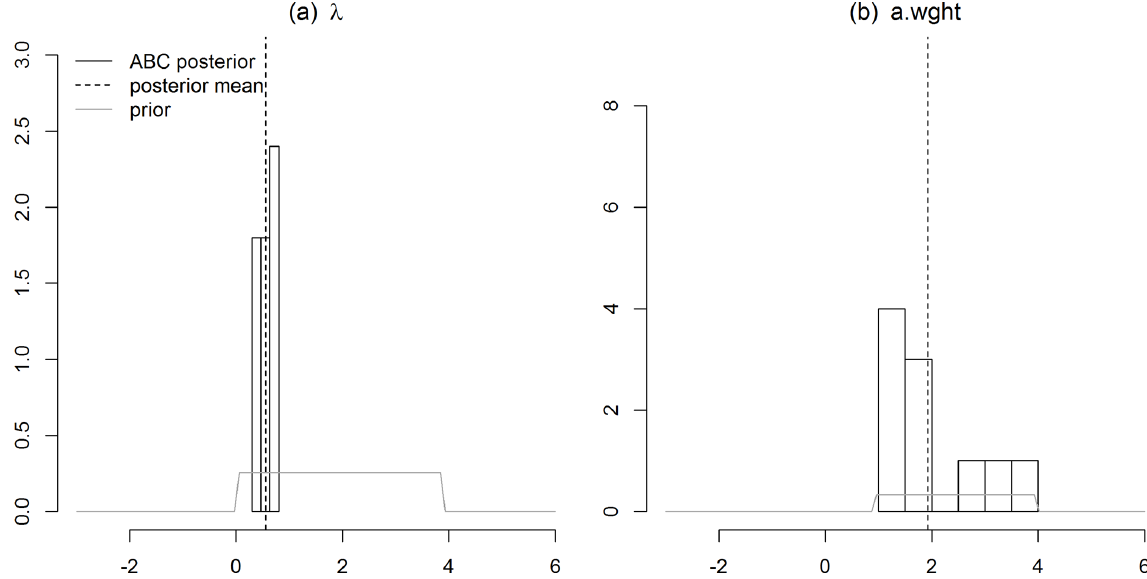
Figure A2. Posterior densities of the smoothing parameter, λ , (a) and autoregressive weight, a.wght (b) , for a HadCRUT4 spatial field with a maximum (78%) spatial coverage, i.e., February